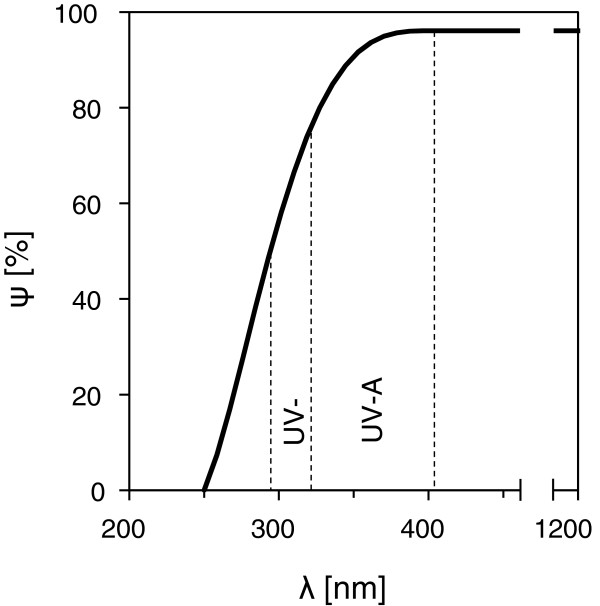
Spectral transmittance of Plexiglas® XT Clear 20070. The material, an extruded acrylic (polymethyl methacrylate) was used for the heat exposure chambers. For visible and near infrared light (1200 nm > λ > 380 nm) it is highly transparent (ψ = 95%). Even the physiological relevant spectral ranges of UV-A (380 nm > λ > 315 nm) and UV-B (315 nm > λ > 280 nm) are transmitted by 80% and 50%, respectively. λ wavelength, ψ spectral transmission. Source: adapted from Röhm GmbH, Darmstadt, Germany.